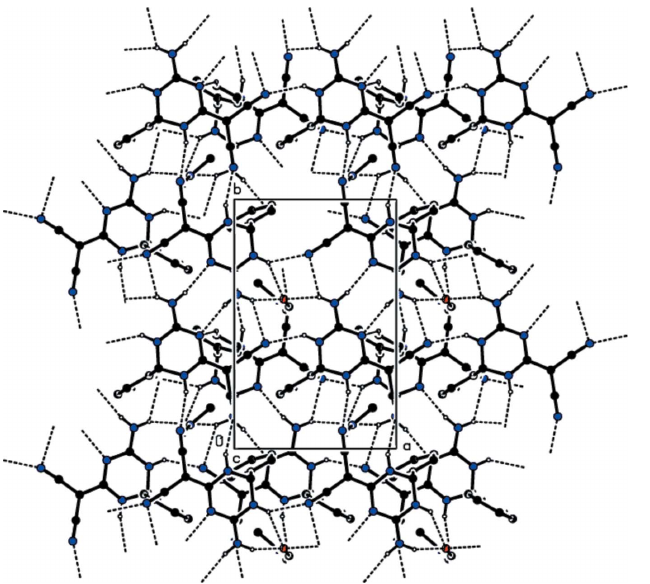
Figure 4 View down the c axis of the N—H (cid:2)(cid:2)(cid:2) N, N—H (cid:2)(cid:2)(cid:2) O and C—H (cid:2)(cid:2)(cid:2) N hydrogen bonds (dashed lines) in the title compound. The minor disordered components have been omitted for clarity.